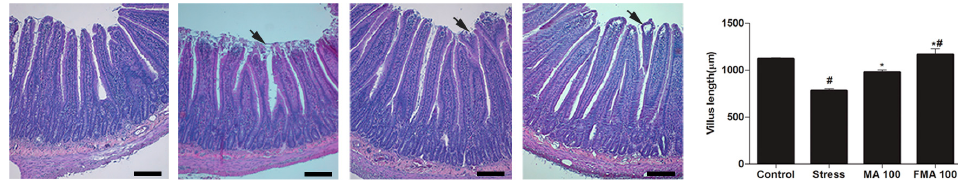
Figure 5. Effect of MA and FMA extracts on duodenum histology and villus length in immobilization stress-induced rats. Rats were administered 100 mg/kg MA (MA 100) and 100 mg/kg FMA (FMA 100) extract 1 h prior to immobilization. Duodenum histology was markedly improved by MA and FMA co-treatment groups as compared to the stress group. The black arrow indicates a damaged mucosal layer of the duodenum. Scale bar 200 μ M. Data are expressed as mean ± standard error (SEM). # p < 0.05 compared with the control and stress group; MA 100 and FMA 100 group, * p < 0.05 compared with the stress group and MA 100 and FMA 100 groups.